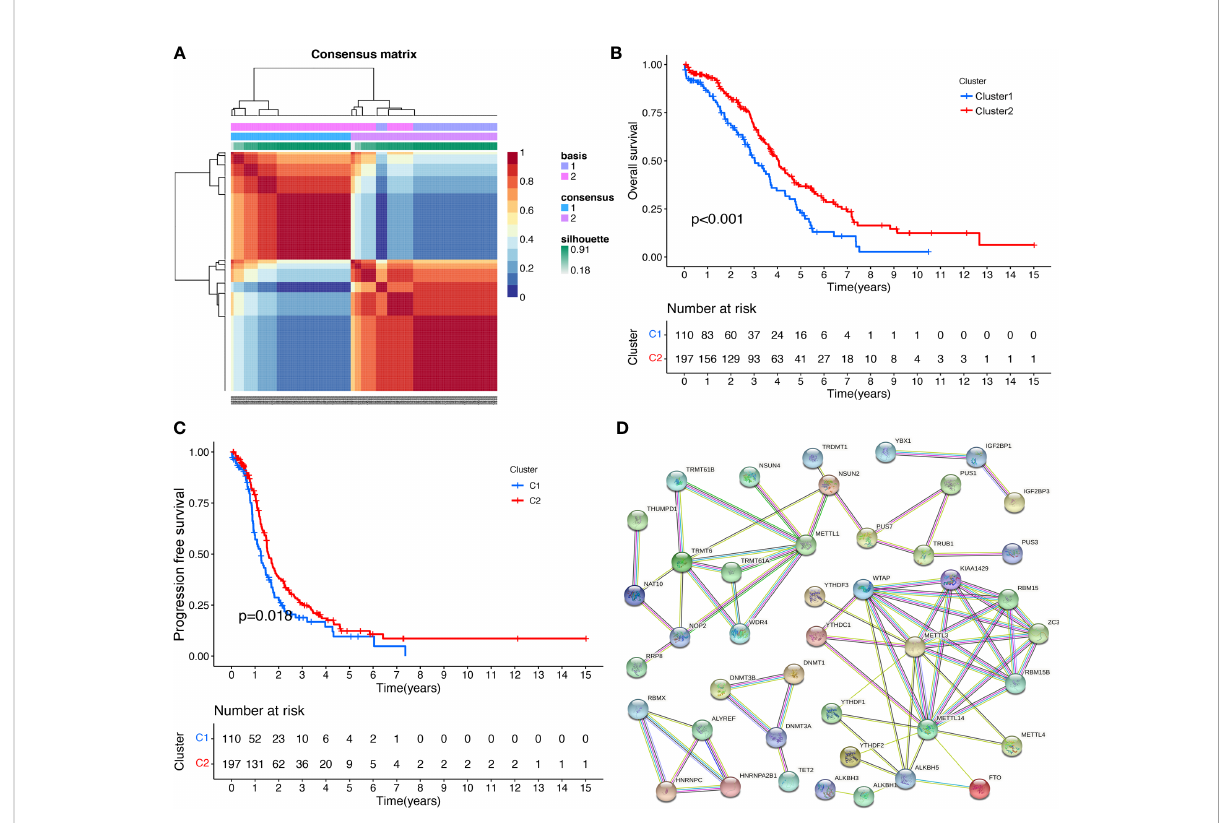
FIGURE 2 The RNA modi fi cation subtypes based on NMF analysis. (A) Clustering heat map of samples at consensus k = 2. Different colors re fl ect different cluster numbers; the color gradient is from white to blue, indicating the consensus of progression. (B) The OS analysis between two RNA- modi fi cation subtypes in ovarian cancer. (C) The PFS analysis between two RNA modi fi cation subtypes in ovarian cancer. (D) The PPI network of RNA-modi fi cation regulatory